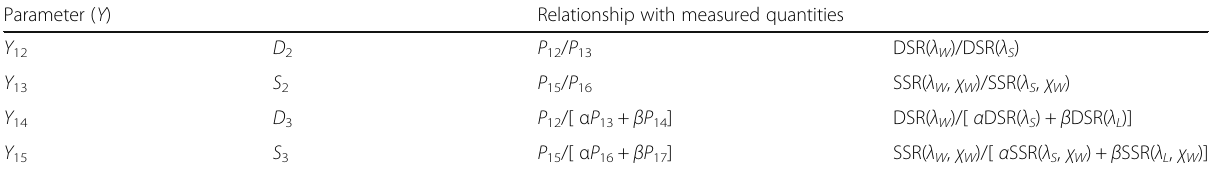
Table 8 Observational parameters ( Y 12 – Y 15 ) for TCWV retrieval Parameter ( Y ) Relationship with measured